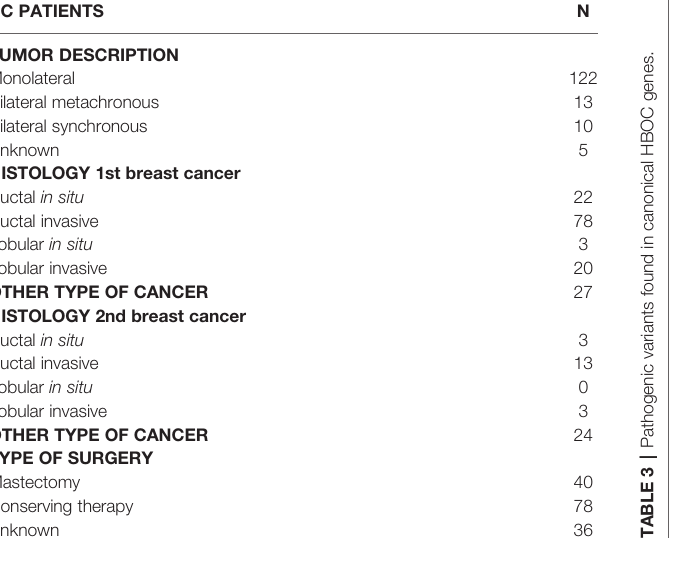
TABLE 2 | Clinical characteristics of Breast Cancer (BC) patients. BC